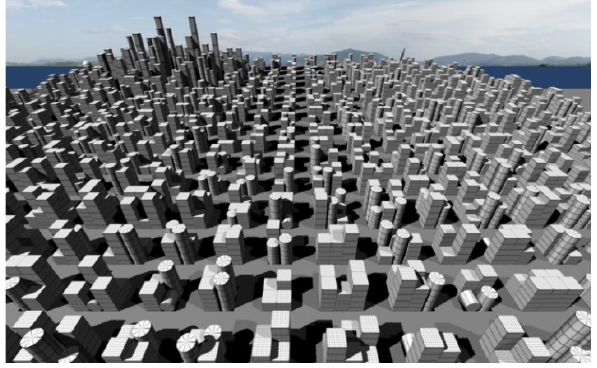
Figure 4. Typical candidate